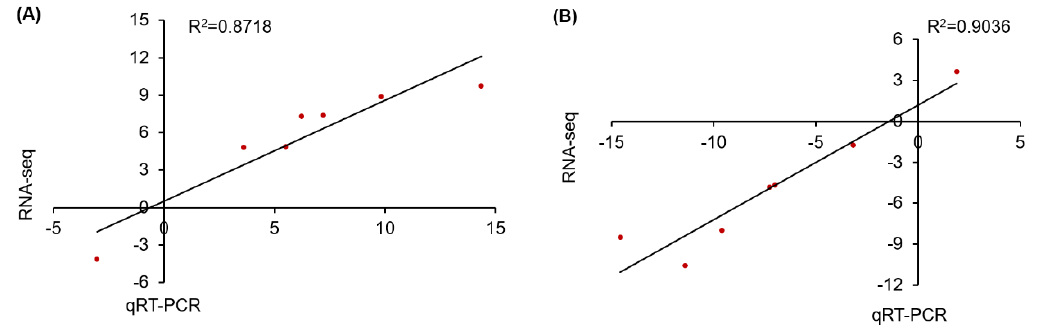
Figure 8. Correlation analysis for expression pattern validation of seven randomly selected DEGs under 100 mM NaCl for 6 h in leaves and in roots ( A , B , respectively) by qRT-PCR. The x-axes and y-axes show the gene transcript level changes obtained by qRT-PCR and RNA-seq, respectively. R 2 indicates the correlation.